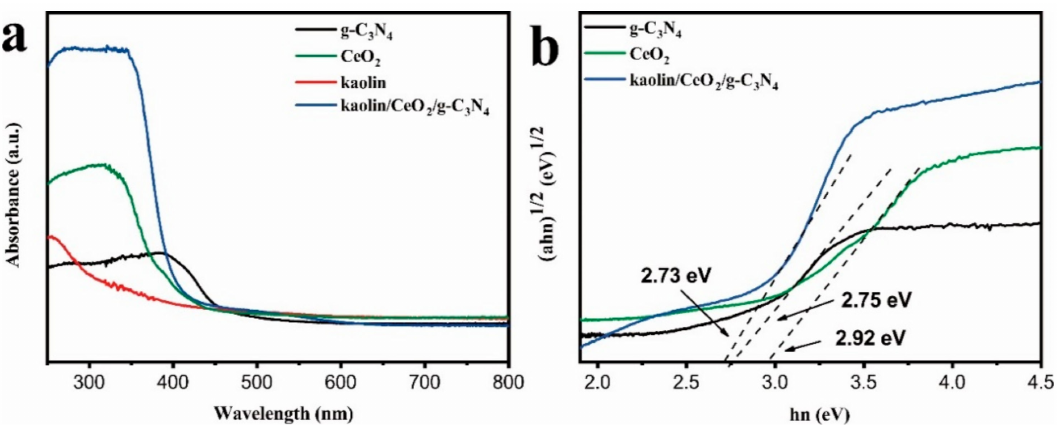
Figure 4. UV-Vis di ff use reflectance spectra (DRS) ( a ) and band gaps ( b ) of kaolin, CeO 2 , g-C 3 N 4 and the kaolin / CeO 2 / g-C 3 N 4 composite.